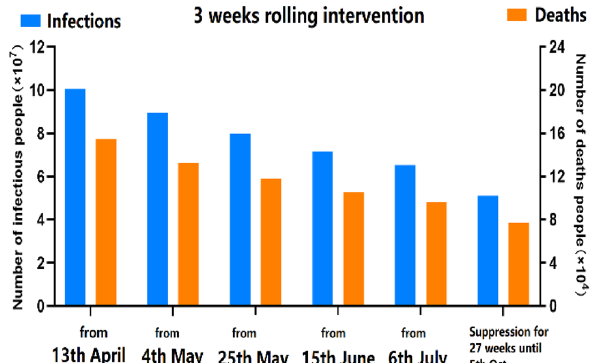
Figure 7. Total infections and deaths in the scenarios of implementing 3 weeks rolling intervention with intensity M = 3 or 5 from different started